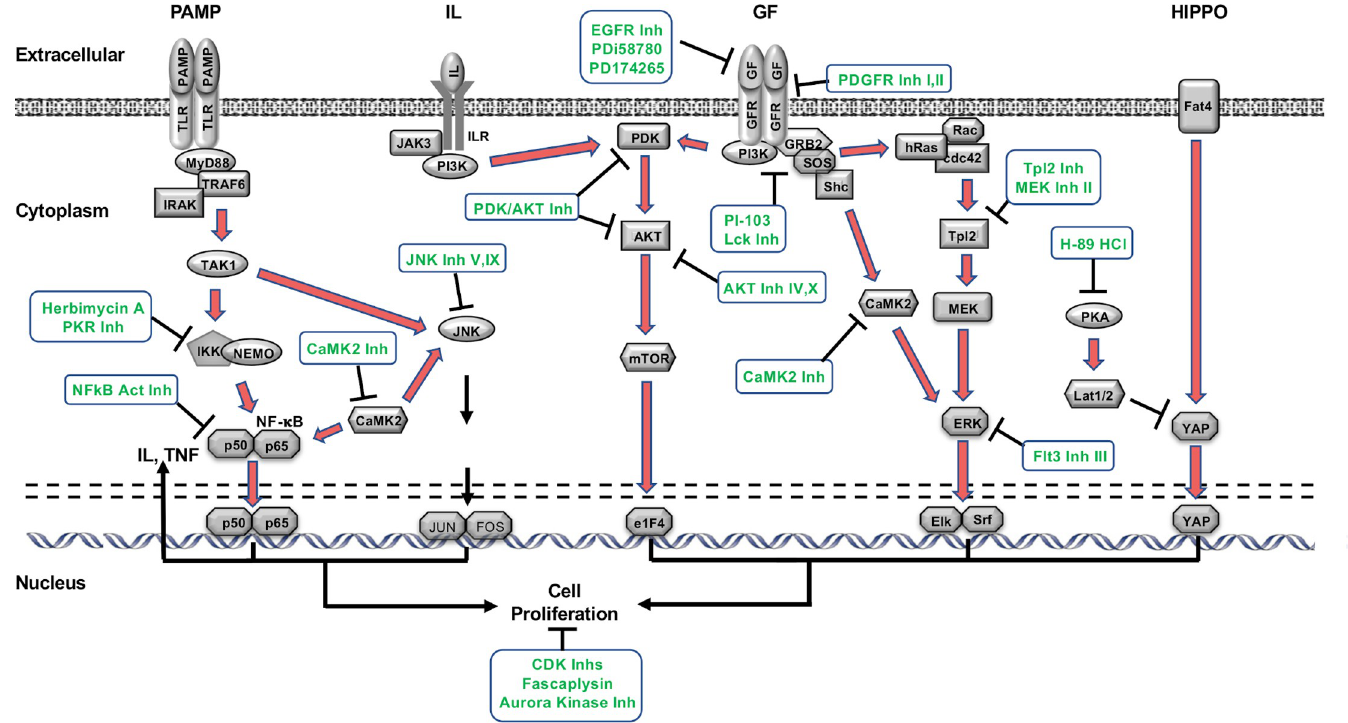
Fig 7. The regulation of ME mucosal growth by kinase pathways. A schematic diagram of signaling pathways identified by the screen as influencing the growth of the ME mucosa in culture. The relevant inhibitors for each pathway are indicated.